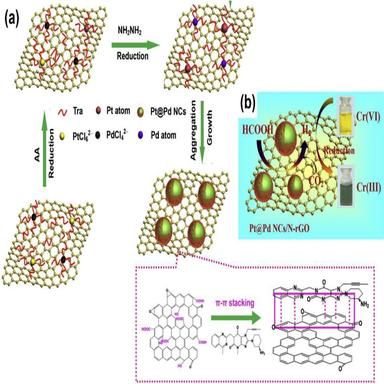
Schematic illustration for the preparation of Pt@Pd NCs/N-rGO and the catalytic reduction mechanism of Cr(VI) on Pt@Pd NCs/N-rGO.